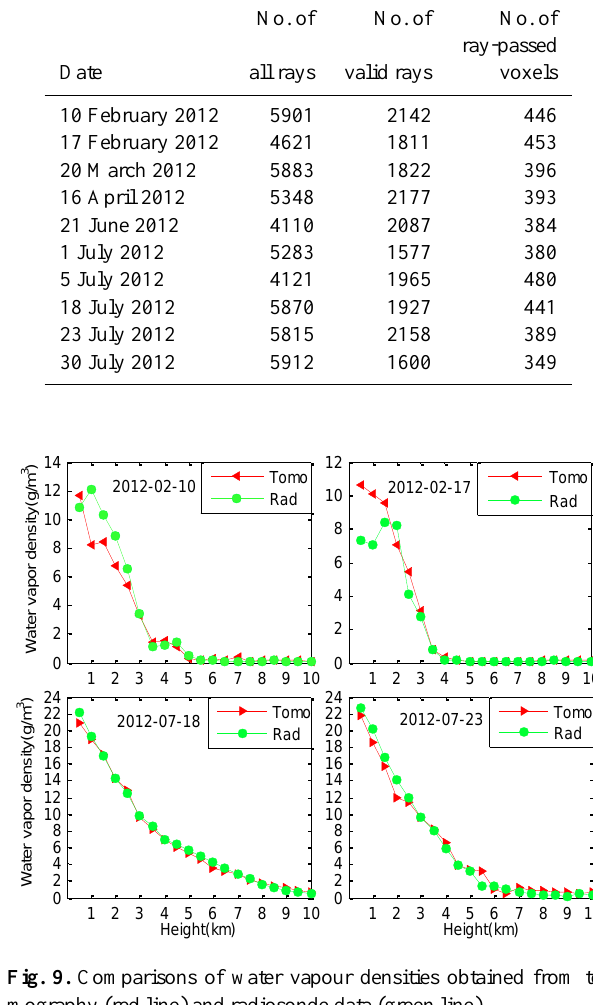
Table 2. RMS of differences between PPP-derived and tomography-derived SWV based on the a priori information of water vapour density acquired from radiosonde data (mm).